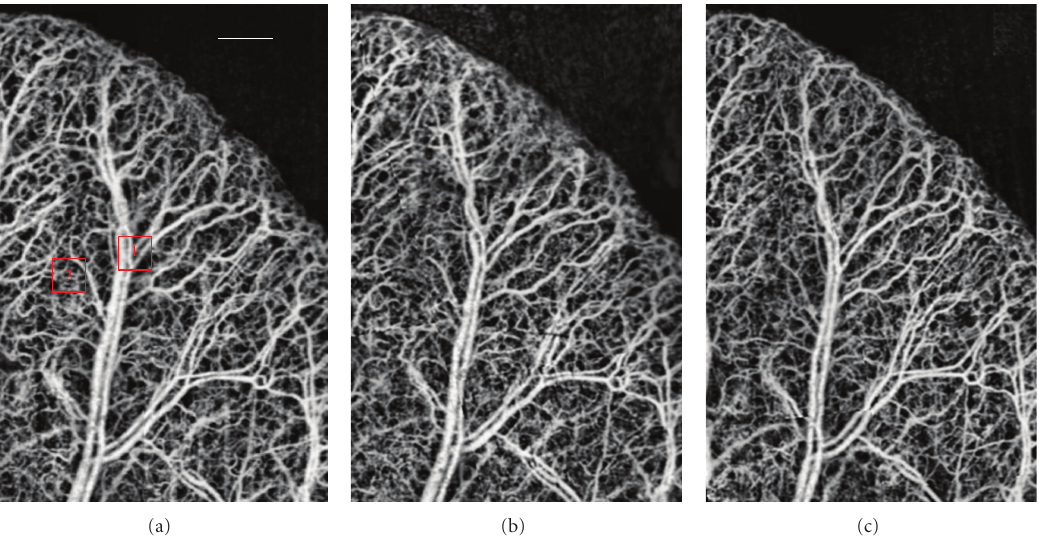
Figure 5: OMAG images obtained from the same mouse ear at day (a) 1, (b) 2, and (c) 3. Scale bar is 0.5mm.